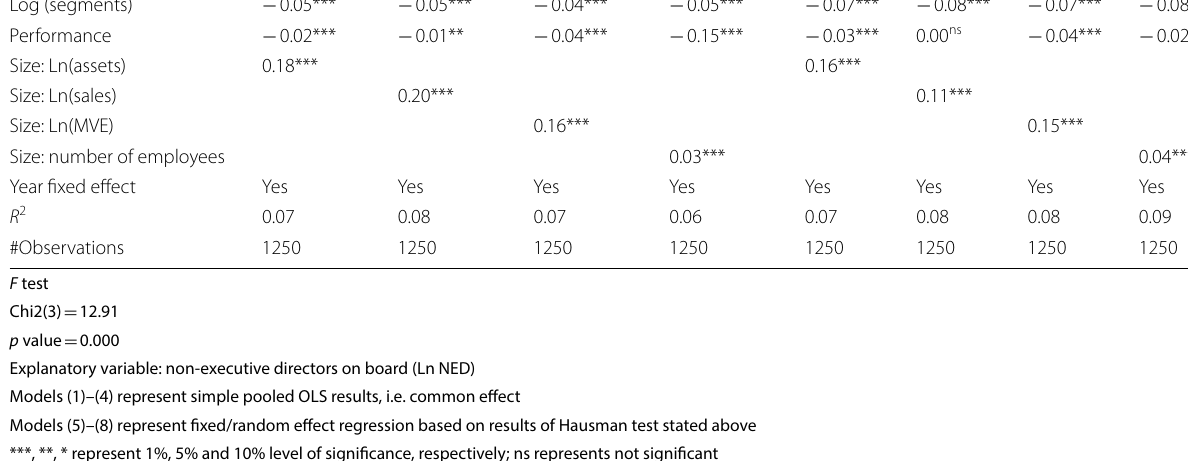
Firm size and dividend policy